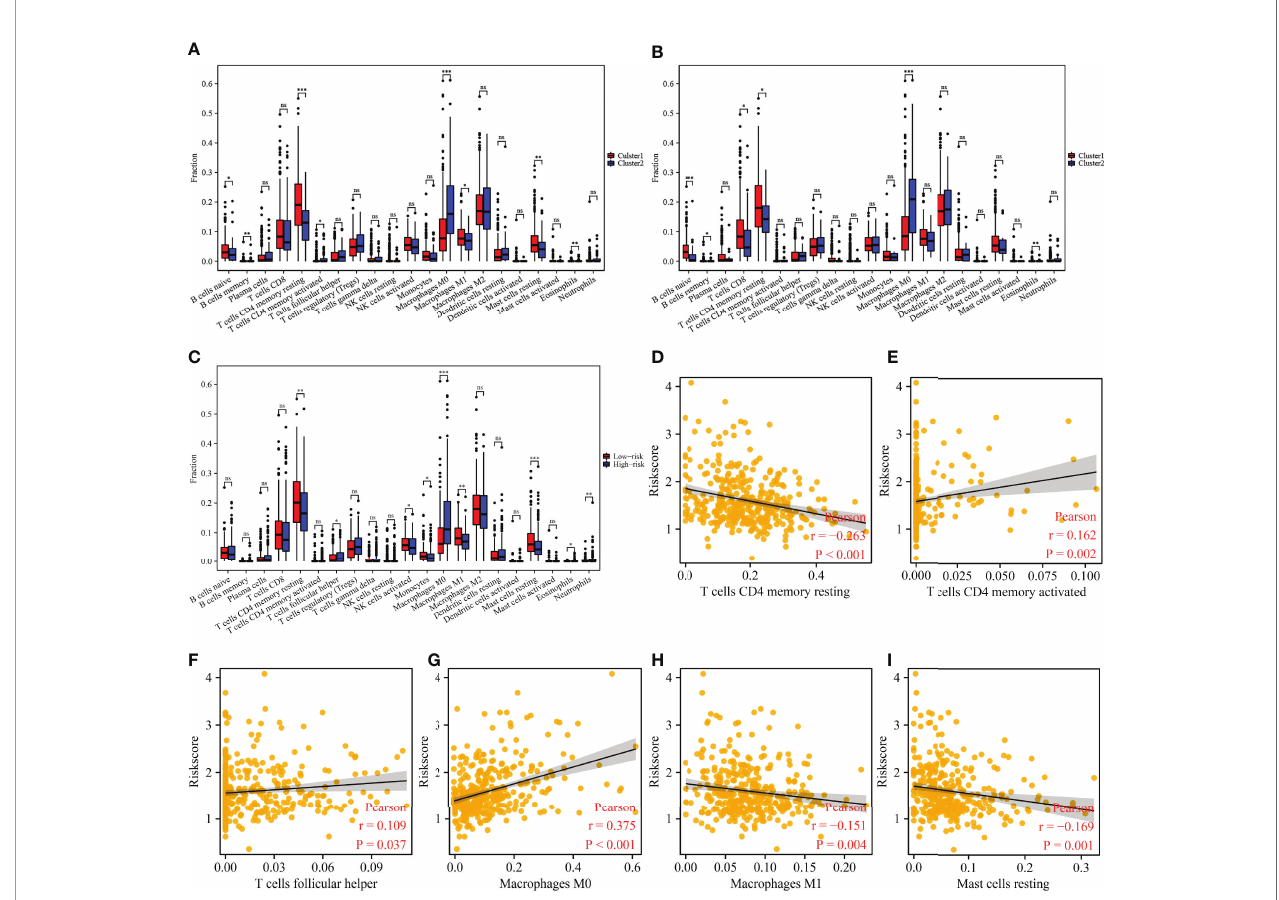
FIGURE 9 | The correlation between the cluster groups and risk model and immune cell in fi ltration in HCC. (A) The expression levels of immune cells in m6A/m1A/ m5C regulated gene subgroups. (B) The expression levels of immune cells in 37 cluster-related DEG subgroups. (C) The expression levels of immune cells in high- and low-risk groups. (D – I) Correlation between the risk model and immune cells. HCC, hepatocellular carcinoma; differentially expressed genes; ns, not statistically signi fi cant; *P < 0.05; **P < 0.01; ***P <